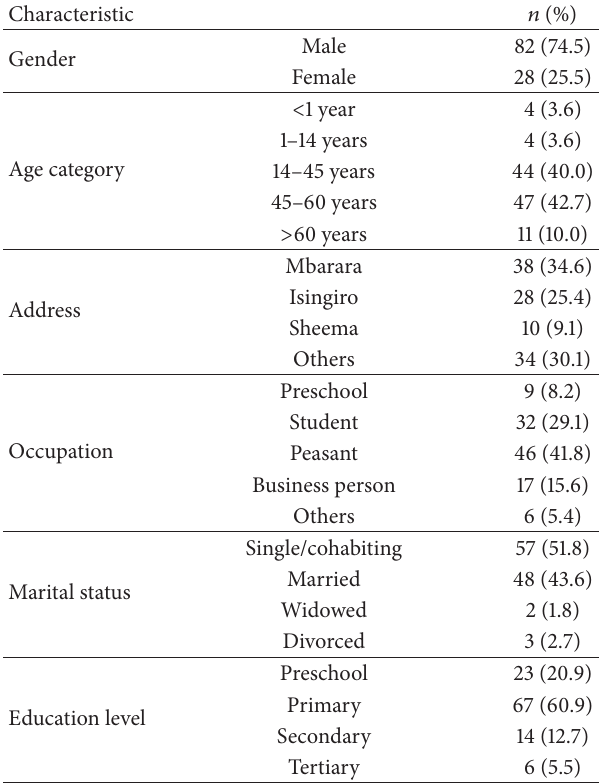
Table 2: Bivariate analysis of risk factors for development of